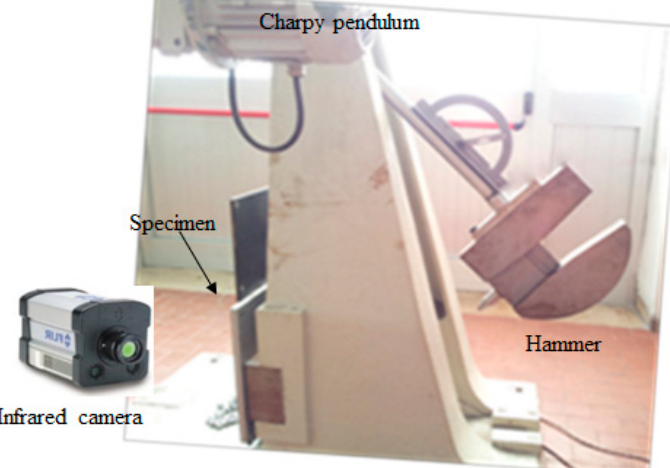
Figure 1. Sketch of the test